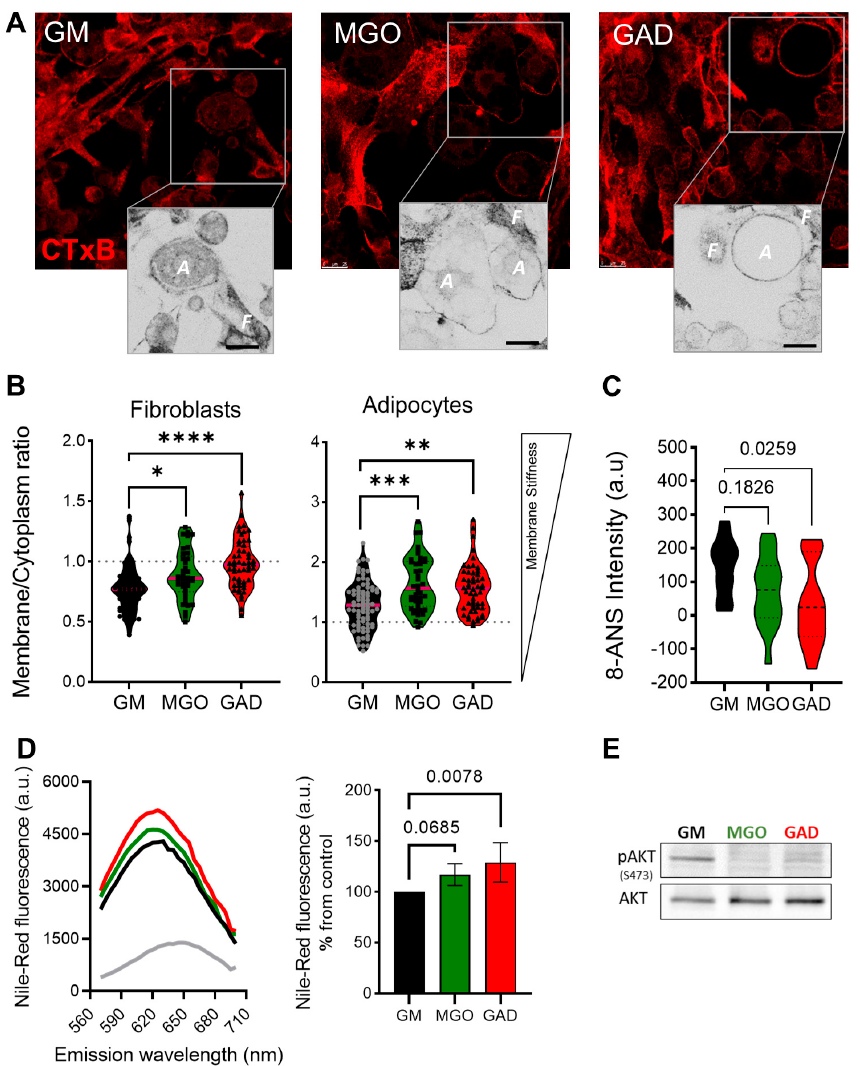
Figure 5. Membrane stiffness and signaling alteration in the MGO and GAD-treated cultures. ( A ) Confocal images of CTxB labeled cells (F–fibroblast, A–adipocyte), enlarged image highlighted with ICA LUTs to emphasize the cells’ membrane intensity (scale bar = 25 µm). ( B ) Quantification of membrane/cytoplasm CTxB expression ratio at the single-cell level, analyzed in fibroblasts and adipocytes (n = 40–80 cells per group). ( C ) The 8-ANS spectroscopy of the GM culture lysate compared to MGO and GAD-treated cells (n = 6). ( D ) Spectroscopy of treated adipocytes in the presence of Nile red: fluorescence spectrum with blue shift peak (right), and peak value quantification (left, n = 4). ( E ) Western blot analysis of phosphorylated AKT protein (pAKT ser473 ) compared to total-AKT in GM, MGO and GAD-treated adipocytes. Results presented as mean ± SD, statistically analyzed by one-way ANOVA. (* p < 0.05, ** p < 0.01, *** p < 0.001, **** p < 0.0001)